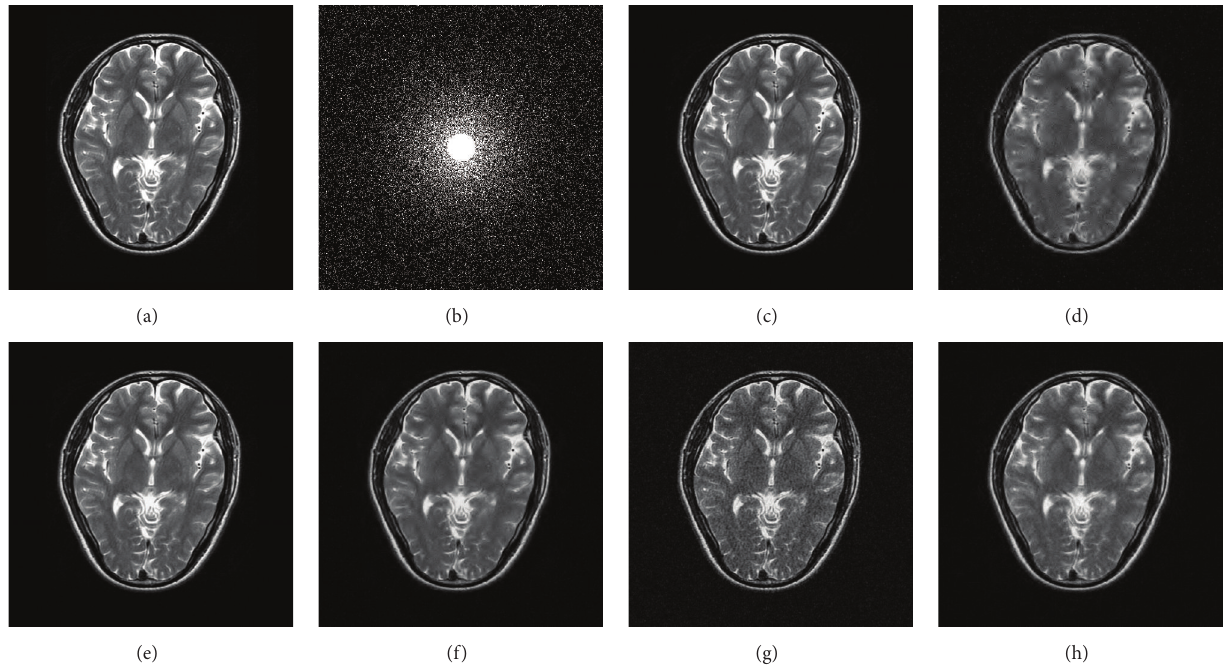
Figure 1: Comparison of CS-MRI reconstruction results obtained from different algorithms. (a) Original MR image. (b) Variable density sampling pattern with sampling rate 0.2. ((c)–(h)) Reconstructed result from Algorithm 1 with contourlet transform, SparseMRI, ICOTA, FICOTA, SpaRSA, and Algorithm 1 with wavelet transform.